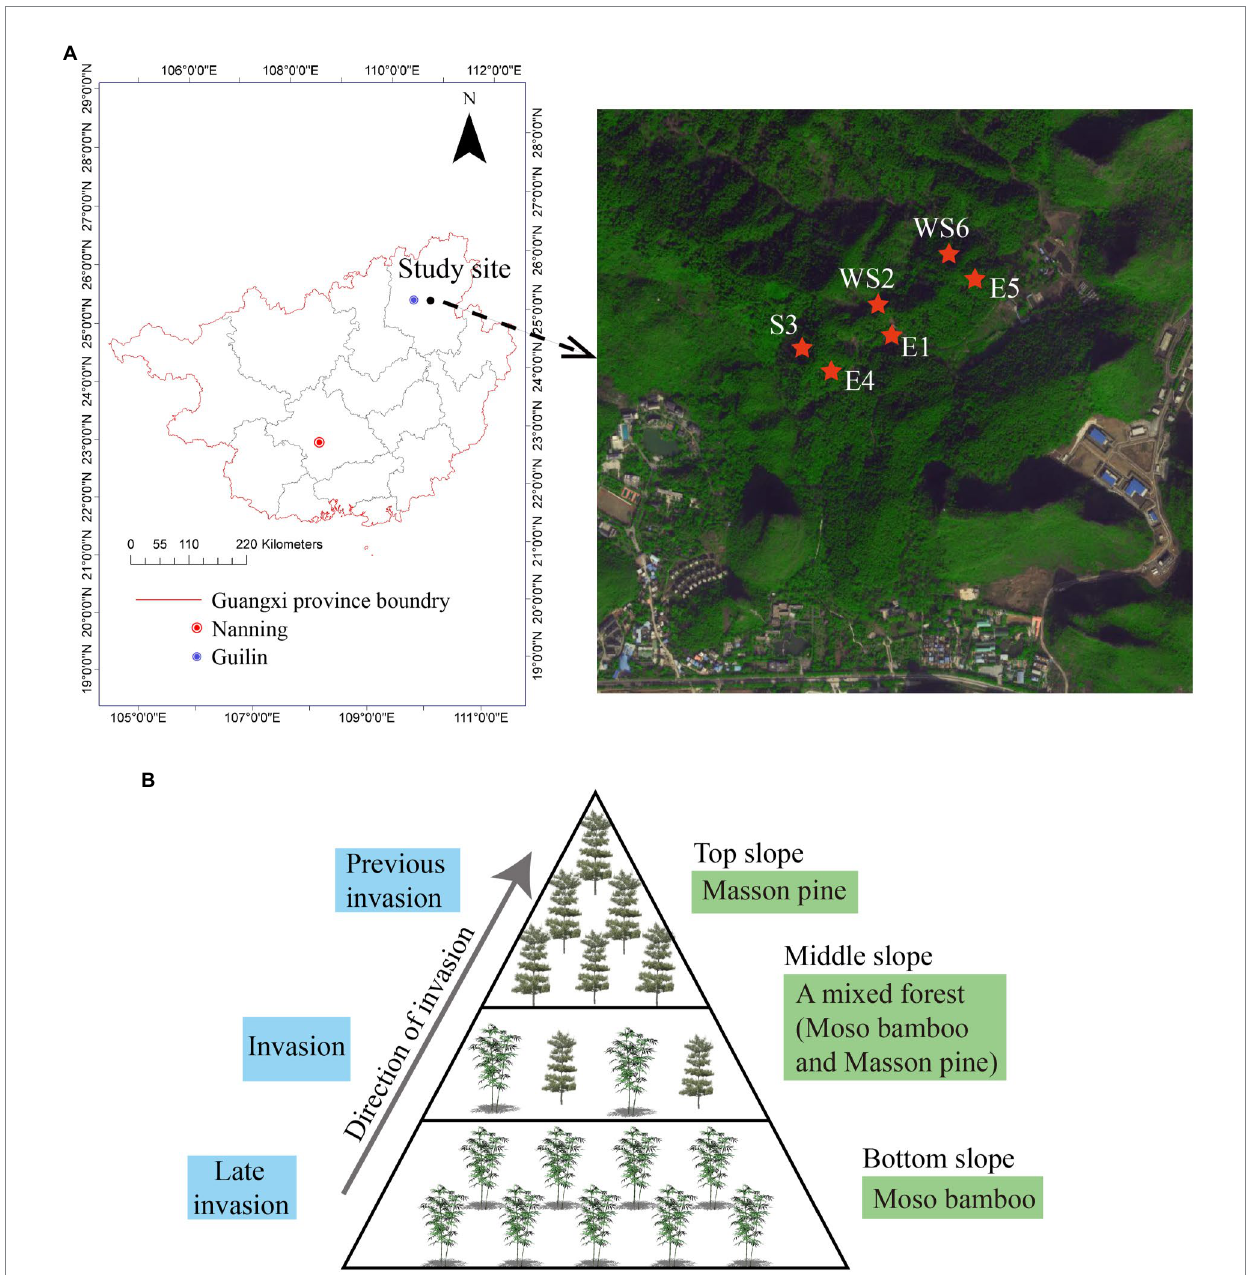
FIGURE 1 Study area settings of different slope directions (A) and different slope positions (B) in Guilin National Forest Park.